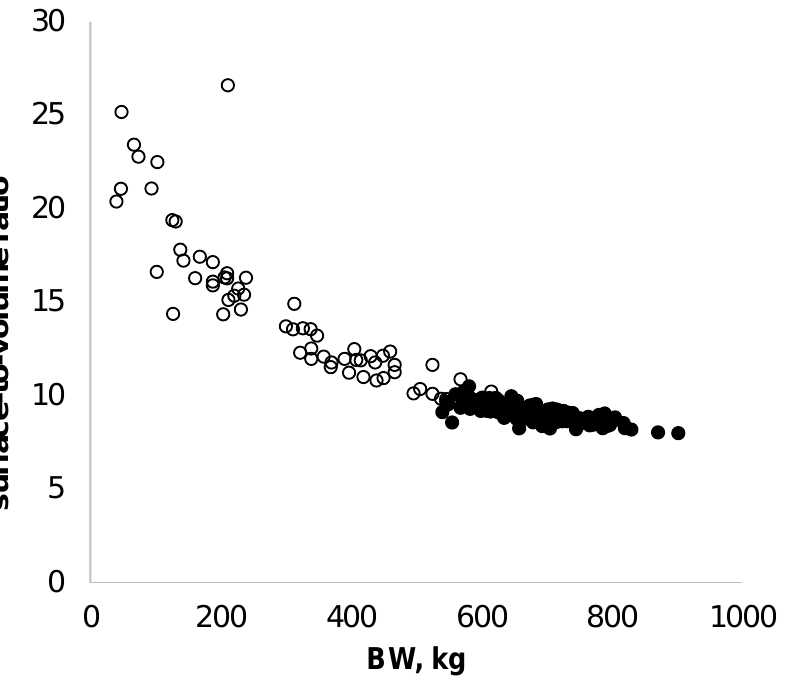
Figure 4. Changes in surface-to-volume ratio as a function of body weight for five Holstein heifers, from 5 weeks of age until the end of gestation (empty circles; n = 68 observations), supplemented with data from adult cows (full circles; n = 177 observations).